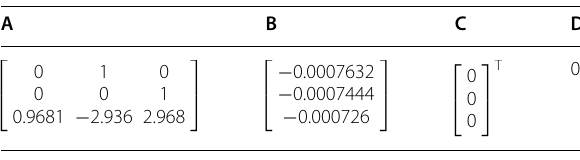
Table 1 Coefficients of state space equation of the linearized model